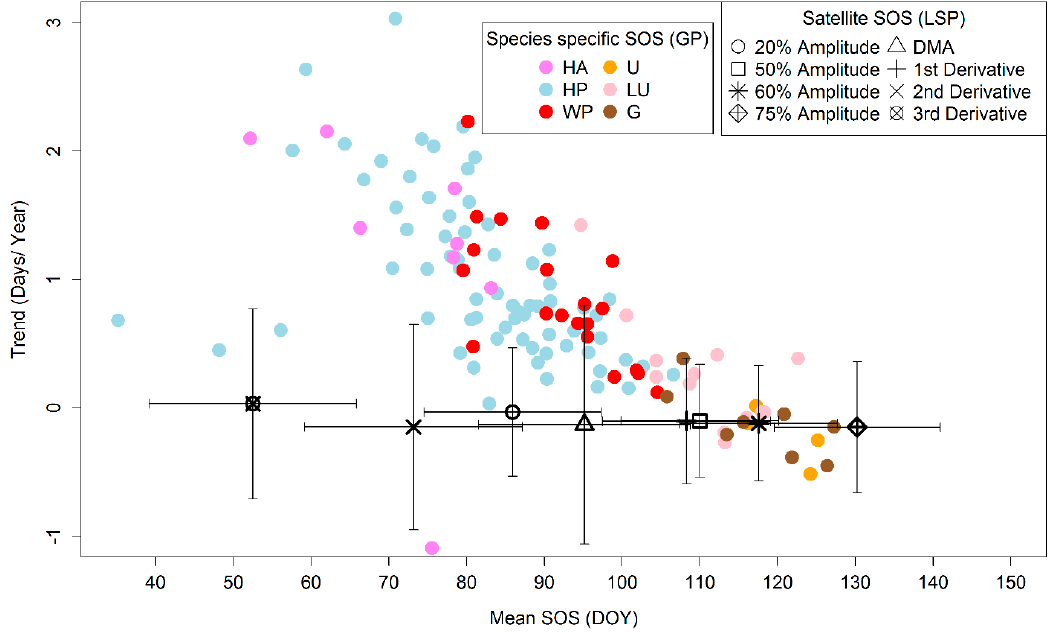
Figure 5. Comparison of LSP-SOS from Gaussian smoothed NDVI (mean LSP-SOS as special symbols in black and one standard deviation as error bars) and various species-specific GP-SOS (as filled and coloured circles, refer to Supplementary Table S1). Numbers are given in order of increasing mean